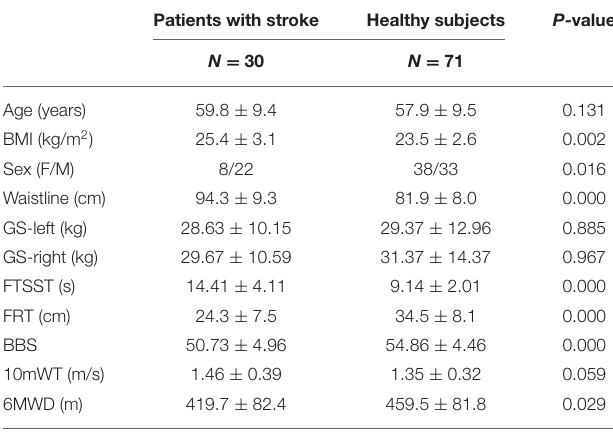
TABLE 1 | Demographic and clinical characteristics related to cardiorespiratory fitness (CRF) of the two groups. Patients with stroke Healthy subjects P